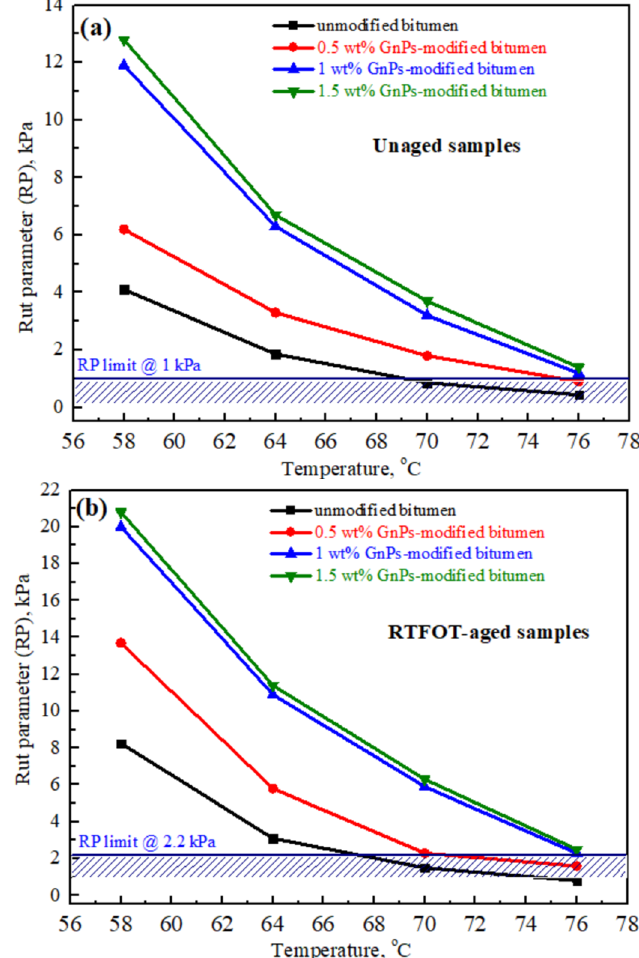
Figure 9. Rut parameter of unmodified asphalt and its GnPs nanocomposites after conditions of ( a ) unaging and ( b ) RTFO-aging.